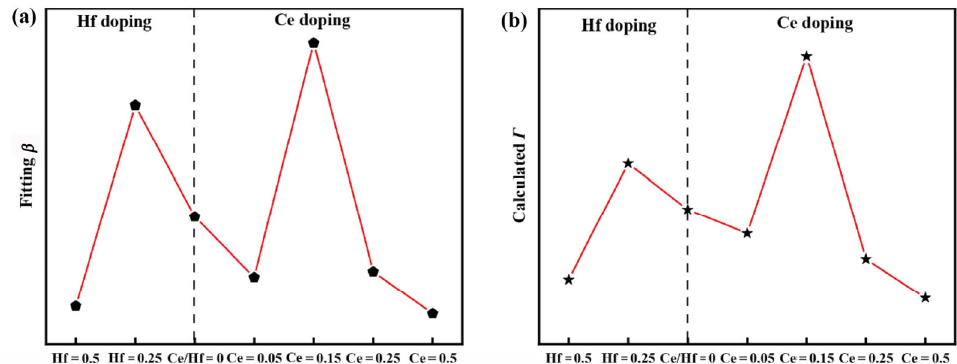
Fig. 10 Fitting β and calculated Г of A 2 B 2 O 7 high-entropy